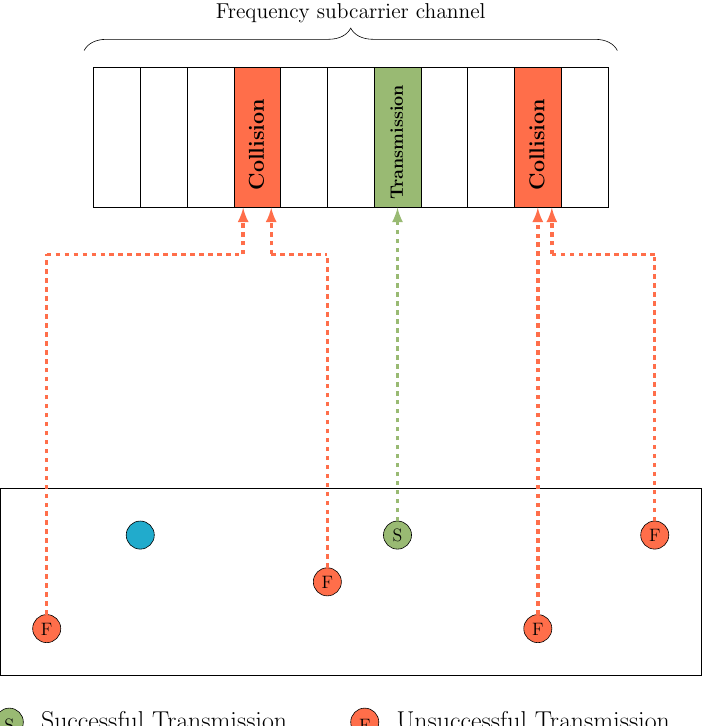
Figure 3. Collision scenario of